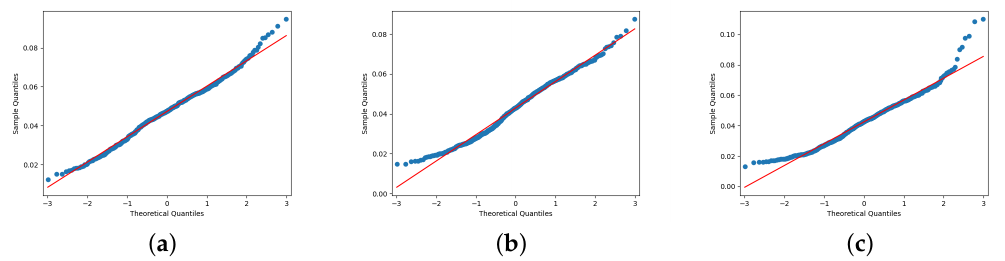
Figure 13. Test of Normal Distribution. Data distribution and fitting results for Portos tomato seedling height. The figures show crops A1, B2, and C3, respectively. ( a ) shows culture A1, ( b ) presents culture B2, and finally, in ( c ), we can see culture